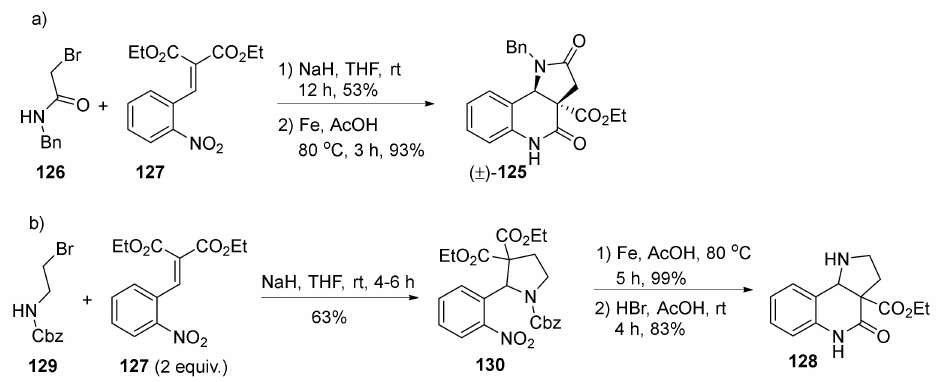
nitrobenzyl-pyrrolidine 130 followed by acidic deprotection of the N -Cbz